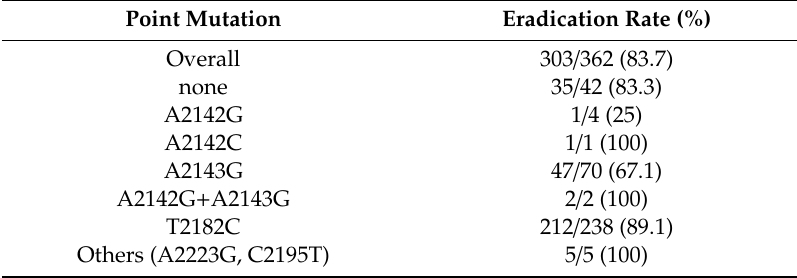
Table 3. H. pylori eradication rates according to clarithromycin resistance-related point mutations ( n =